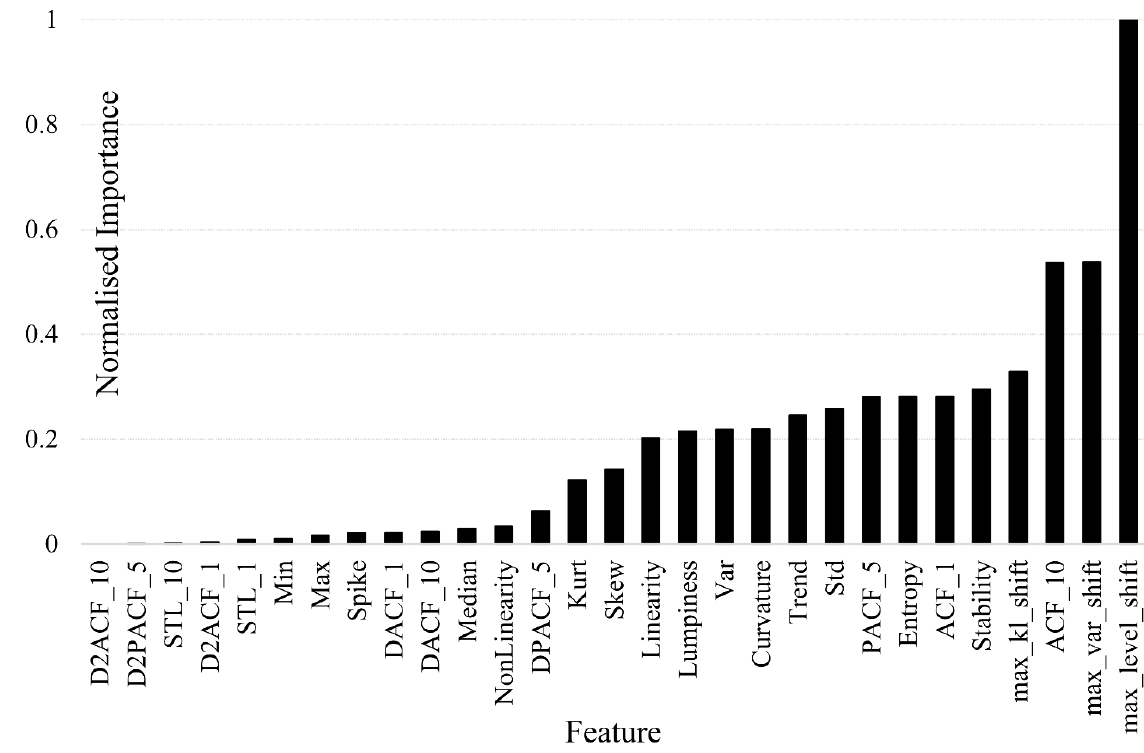
Figure 5. Normalised importance of 29 features using the RF